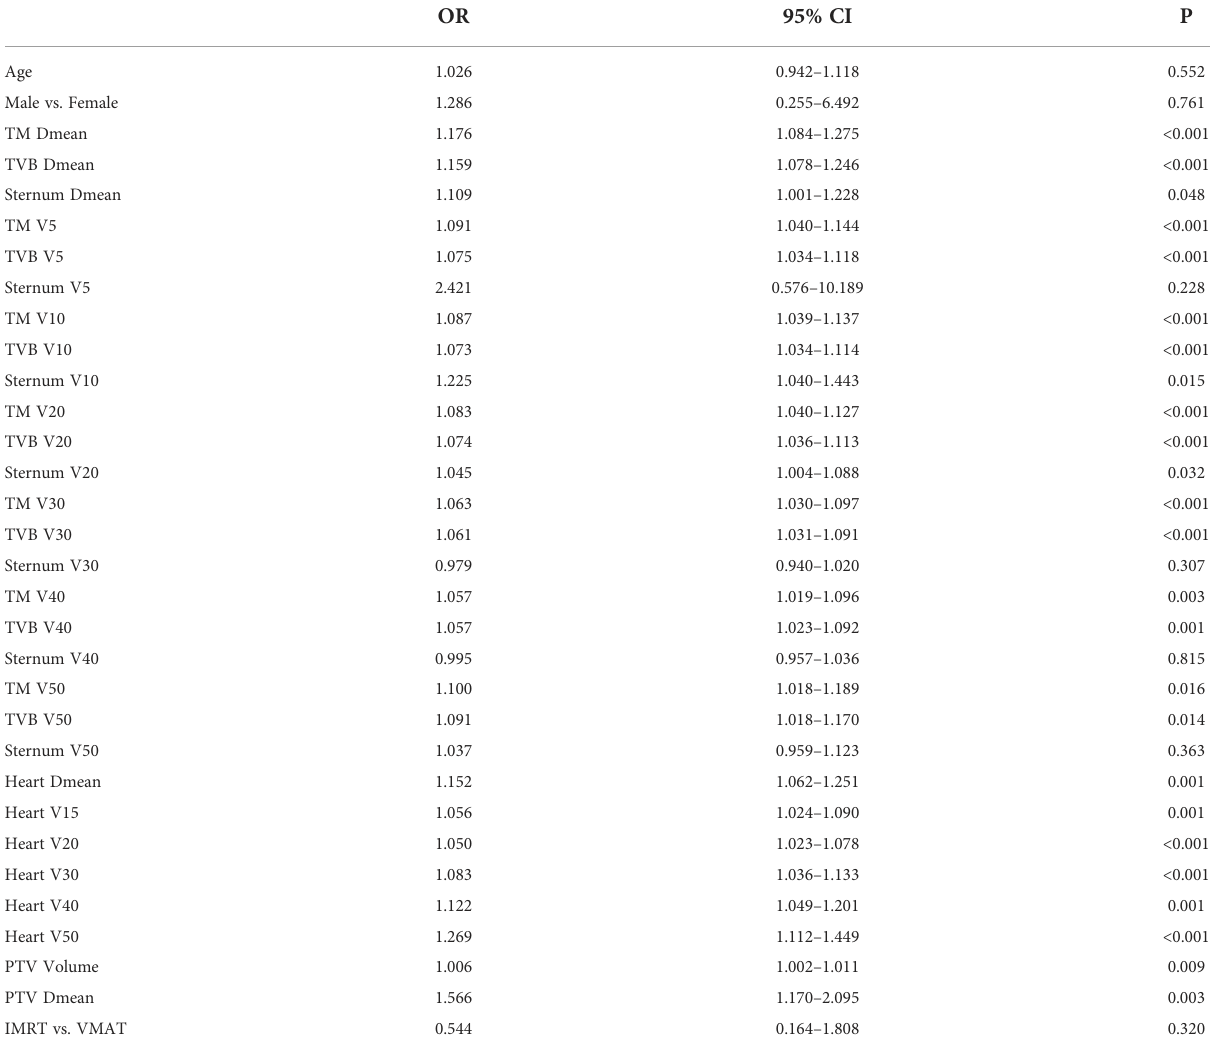
TABLE 3 Logistic regression analysis of factors associated with grade 4